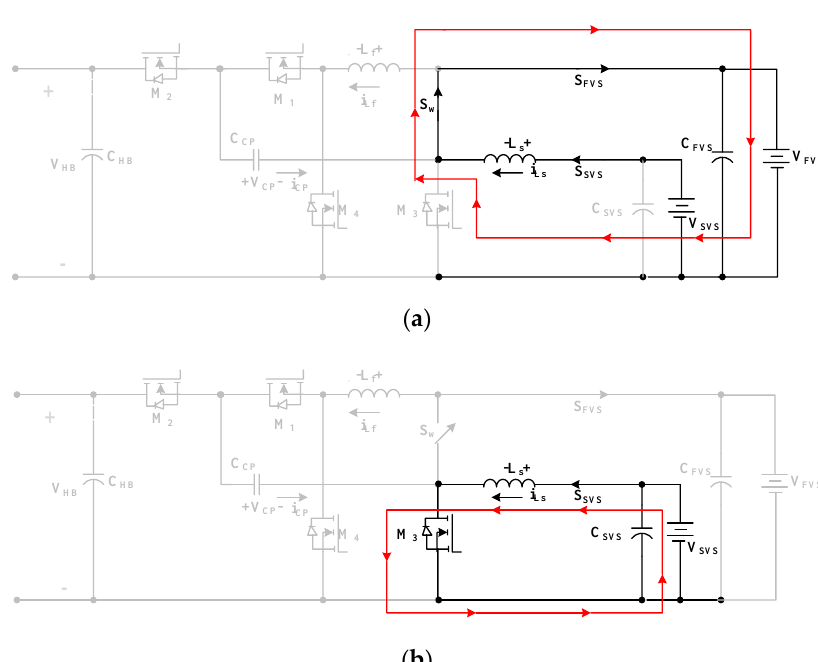
Figure 8. ( a ) Stage 1 ( b ) Stage 2.